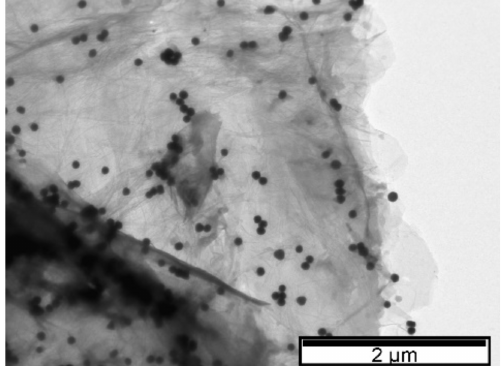
Figure 5. TEM image. GO supported on AuNPs synthesized with 5% tea